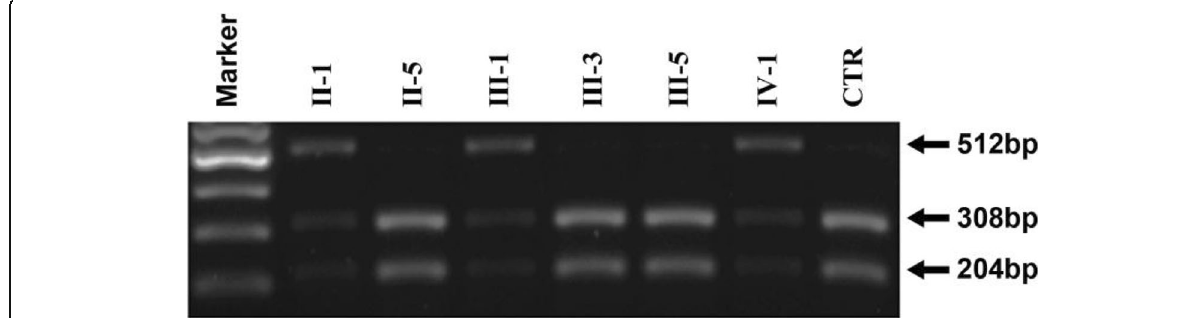
Fig. 3 PCR-RFLP results confirms the identification of c.5417C > A mutation in the MYH14 gene. 512-bp PCR products around c.5417C region were digested with Eco130 I and analyzed by electrophoresis through a 2% agarose gel stained with ethidium